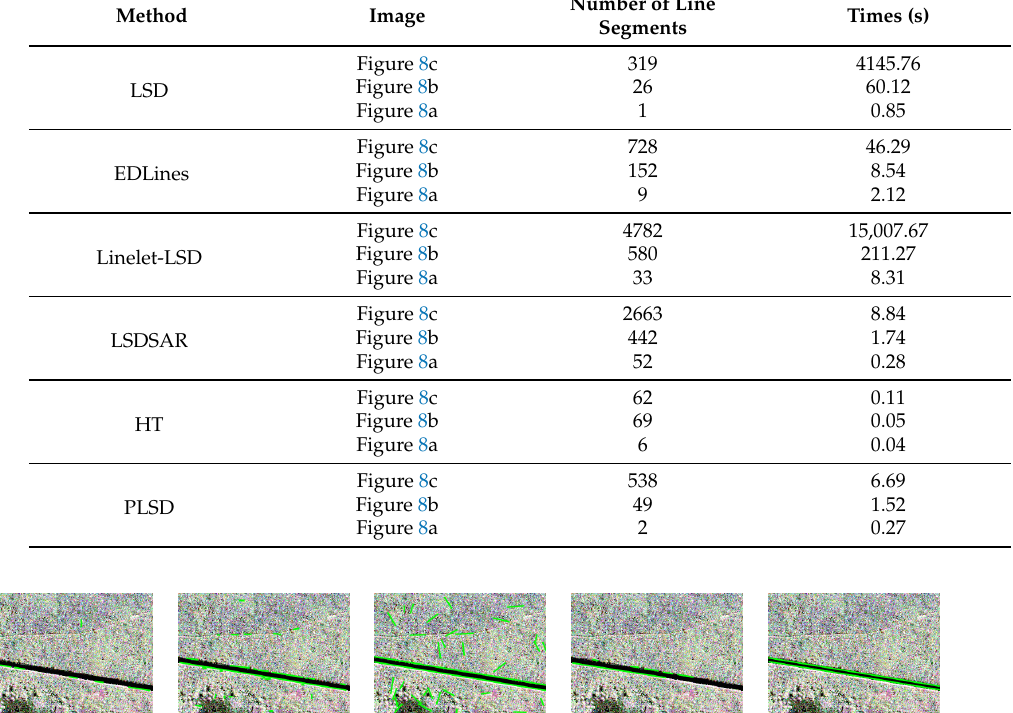
Table 2. Line segment detection results.